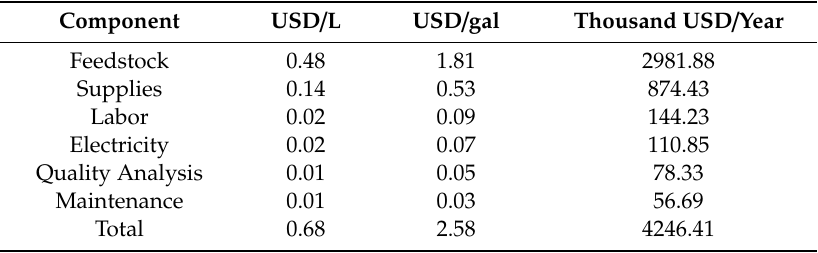
Table 4. Biodiesel production expenses for the proposed